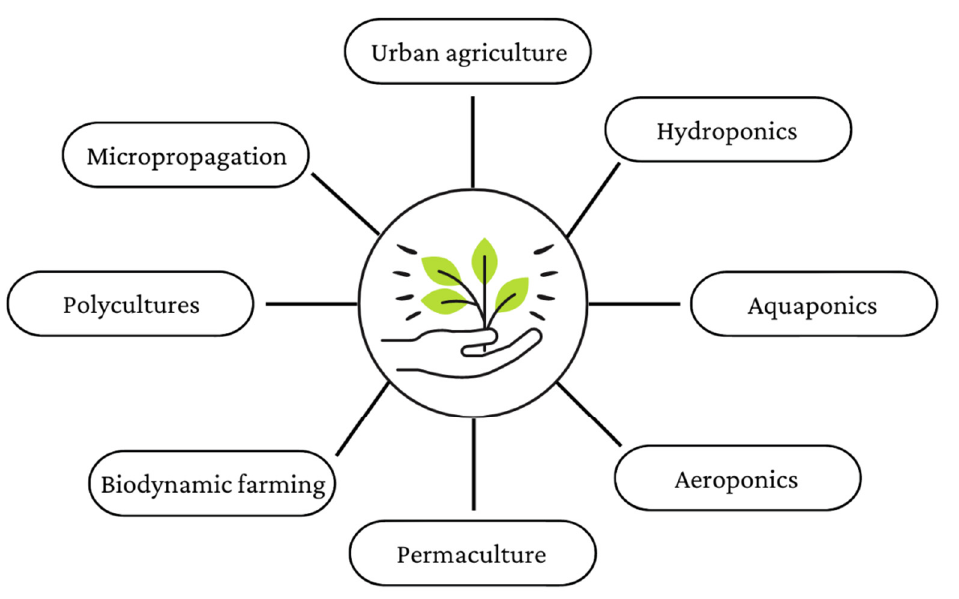
Figure 4. Schematic representation of the main alternative crop cultivation methods (created with Canva.com, accessed on 10 February 2023) .